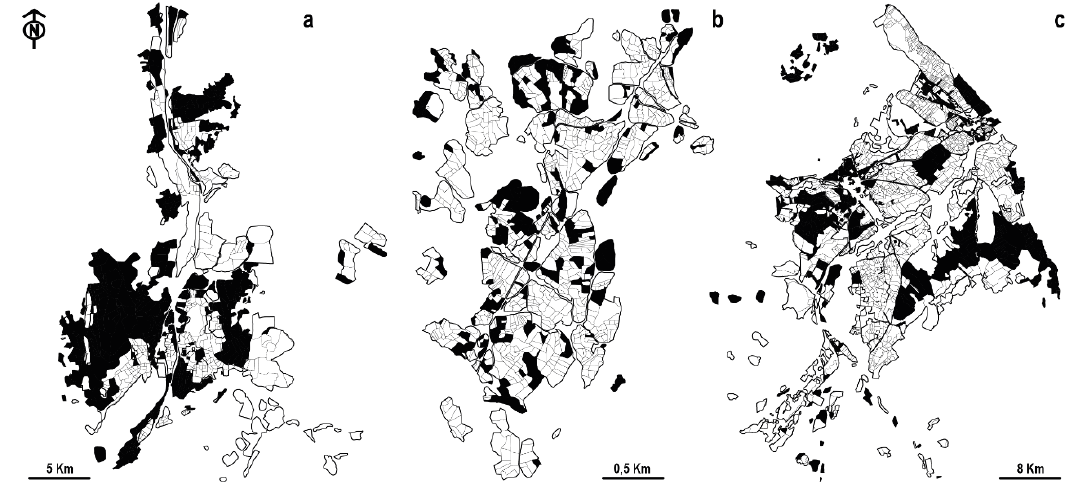
Figure 2. Enclosed fields that have disappeared (in black) between 1956 and 2019 in the three study cases: ( a ). Somosierra; ( b ). Arroyo del Valle—Bustarviejo; ( c ). Rascafría. Own elaboration.